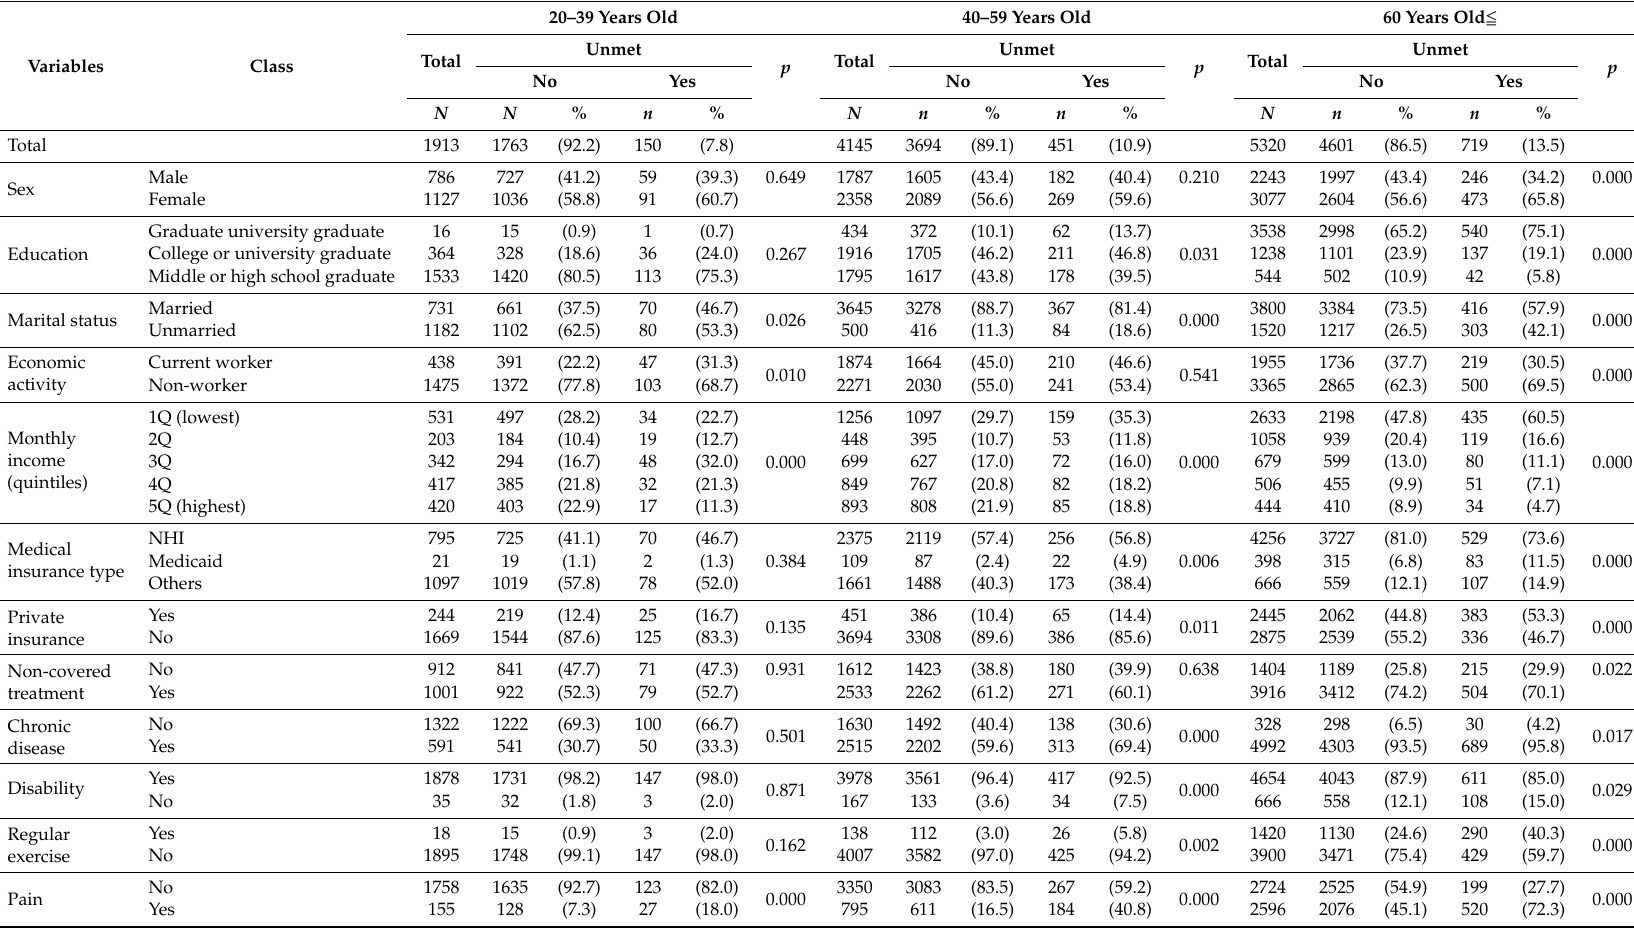
Table 2. Unmet medical needs according to sociodemographic characteristics, stratified by